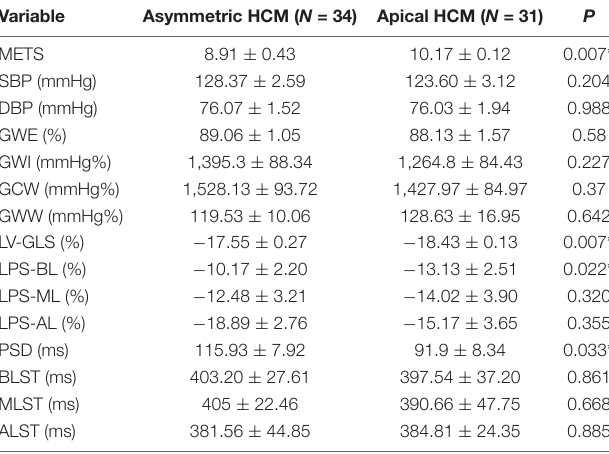
TABLE 3 | Comparison of myocardial work and strain between asymmetric and apical